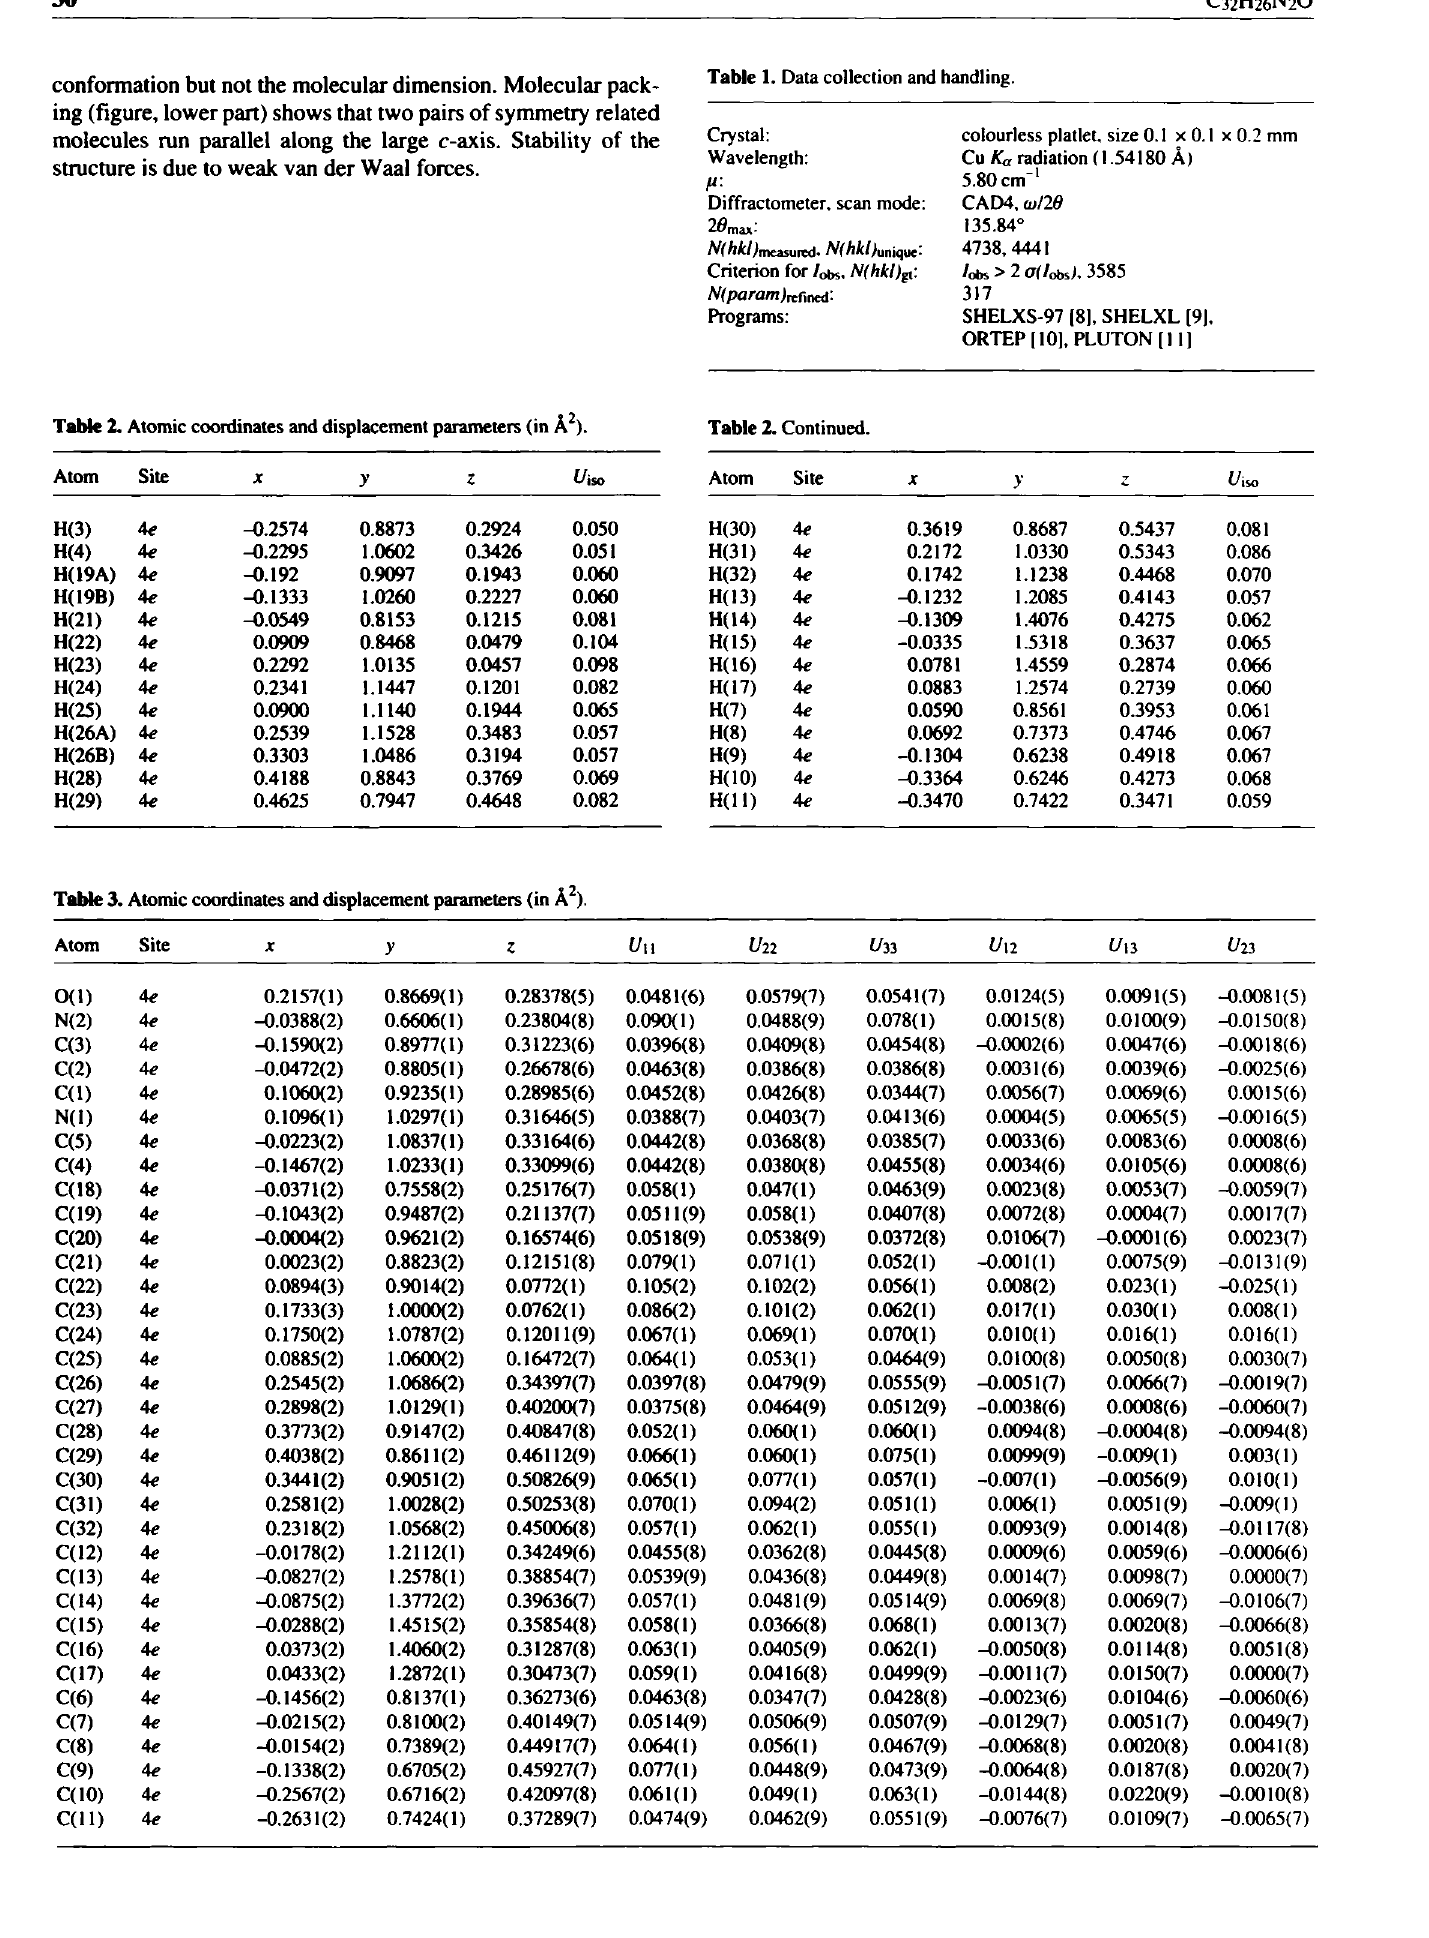
Table 1. Data collection and handling.